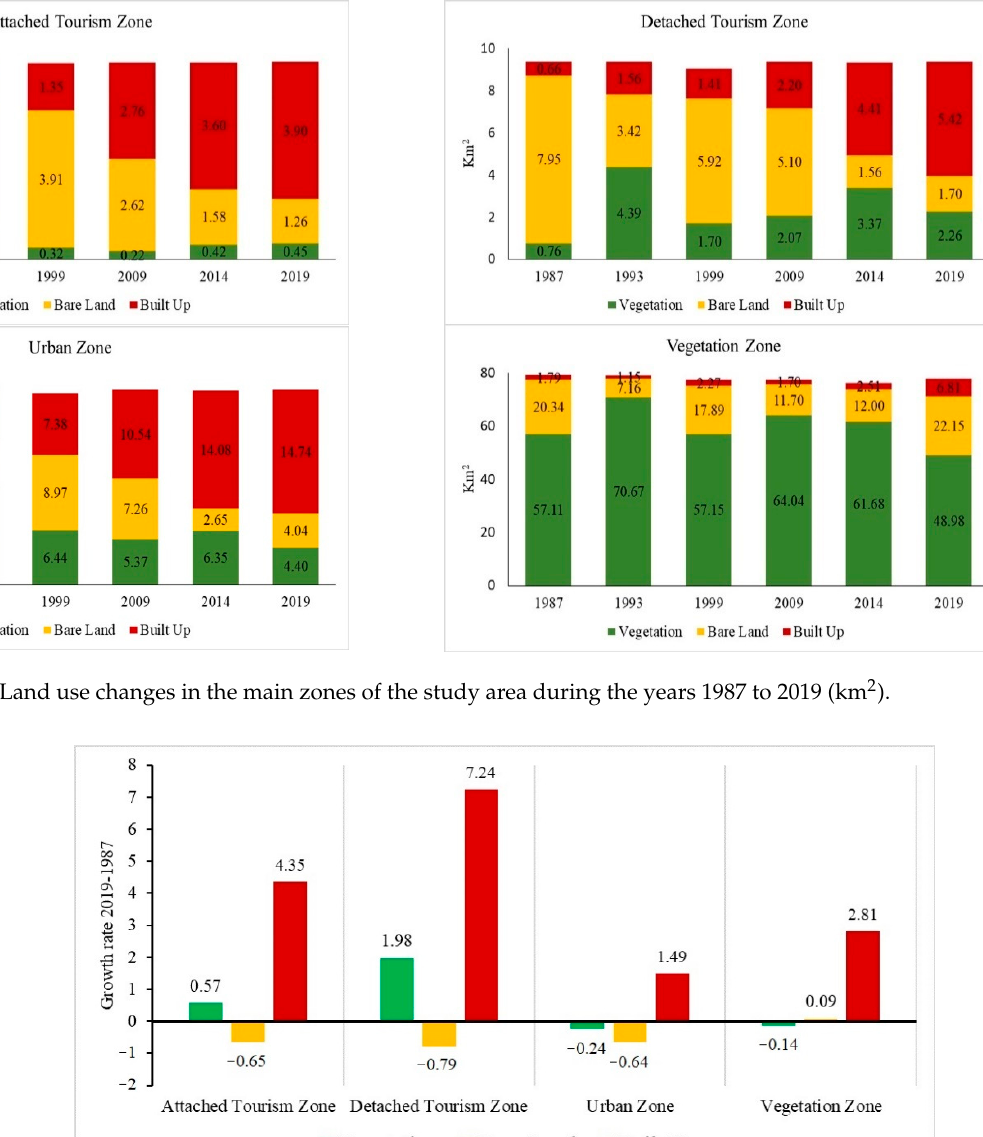
Land 2021 , 10 , x FOR PEER REVIEW